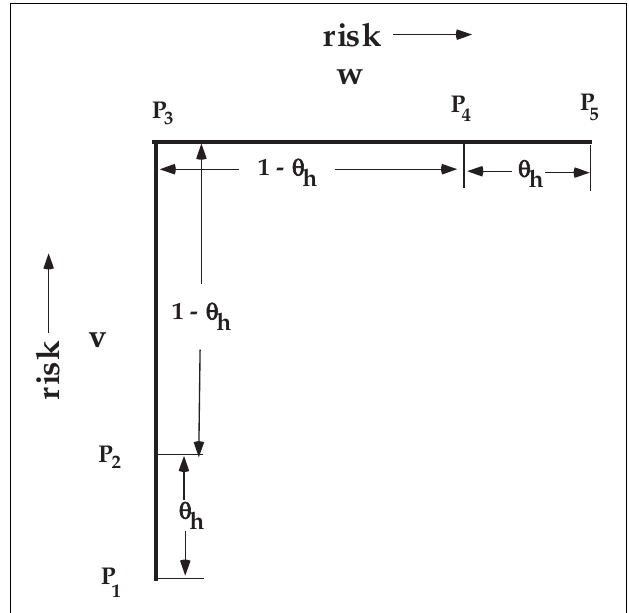
FIGURE 4 | Illustration of the relative position of the v and w variables that determine the points on the PD ROC. See Figure 3 for the definition of the